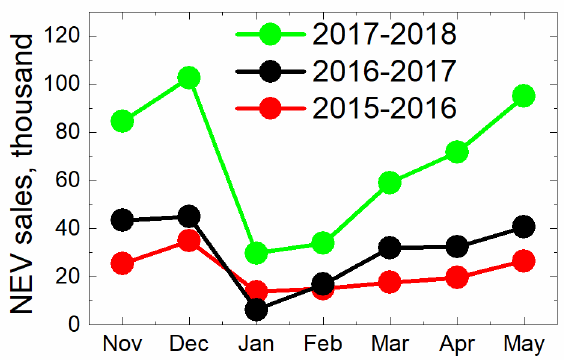
Figure 5. Annual NEV sales drop in China, 2015 – 2018 comparison.